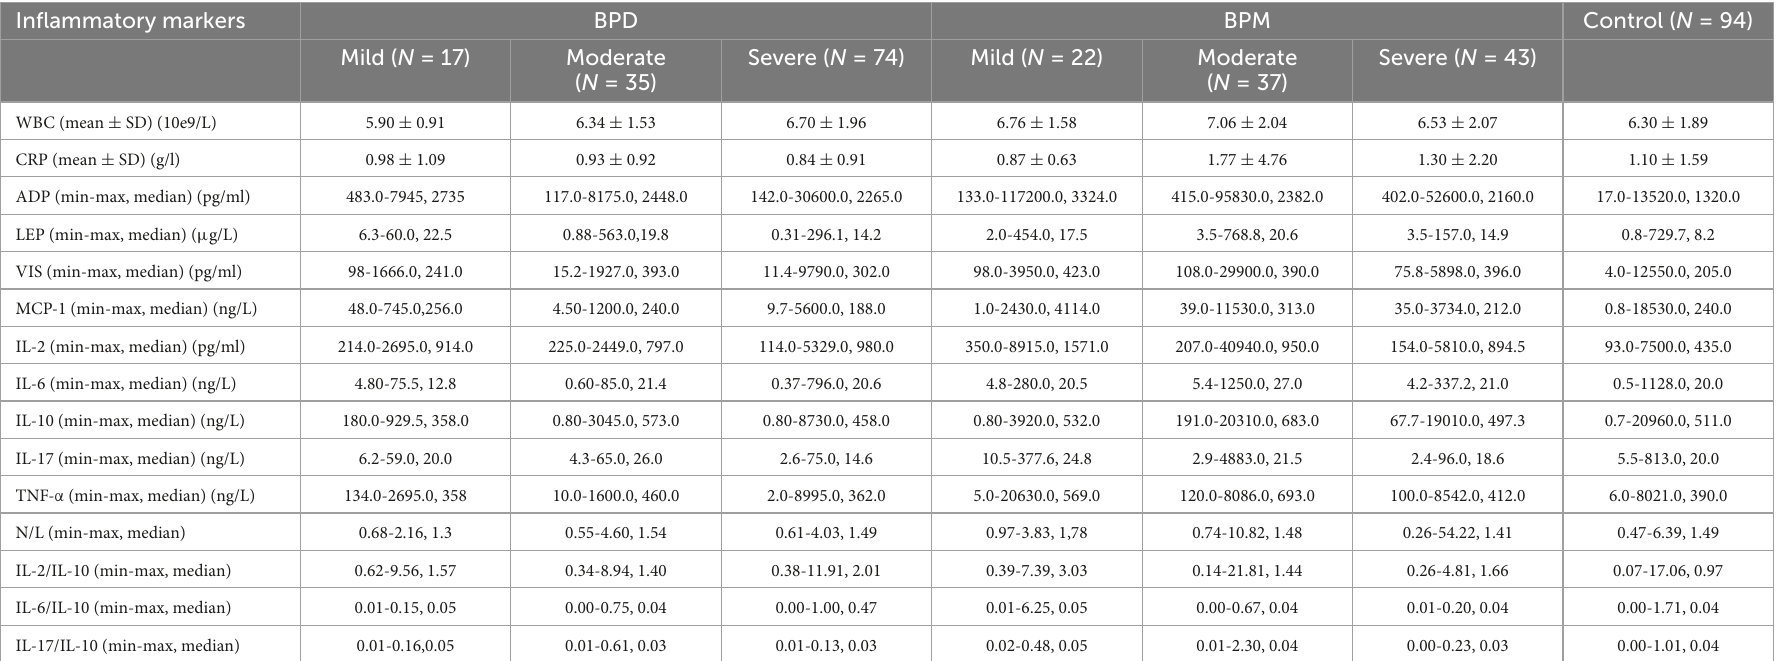
TABLE 4 The serum levels of inflammatory markers of bipolar disorder of different severities. Inflammatory